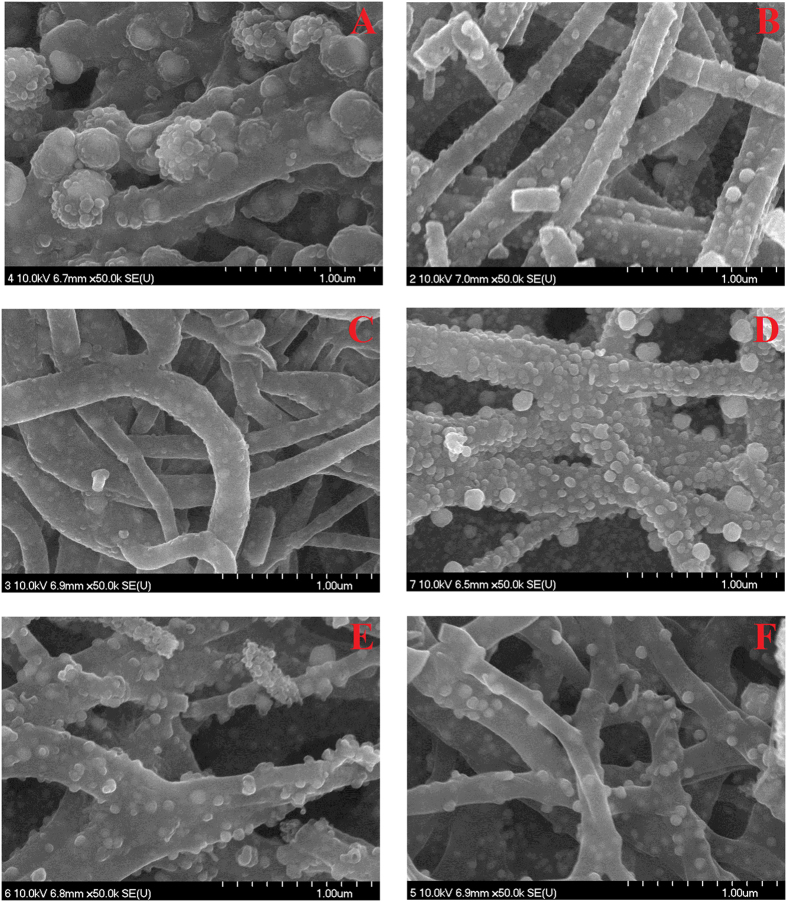
FESEM pattern for the obtained carbon nanofibers containing (A) Cu0%Co100% (B) Cu10%Co90% (C) Cu15%Co85% (D) Cu35%Co65% (E) Cu65%Co35% and (F) Cu100%Co0%, nanoparticles.